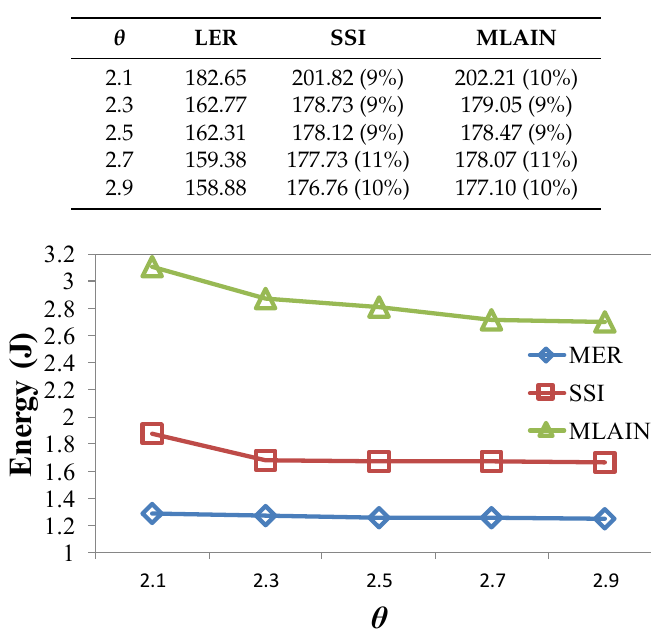
Figure 12. Average energy consumption for changing θ values.